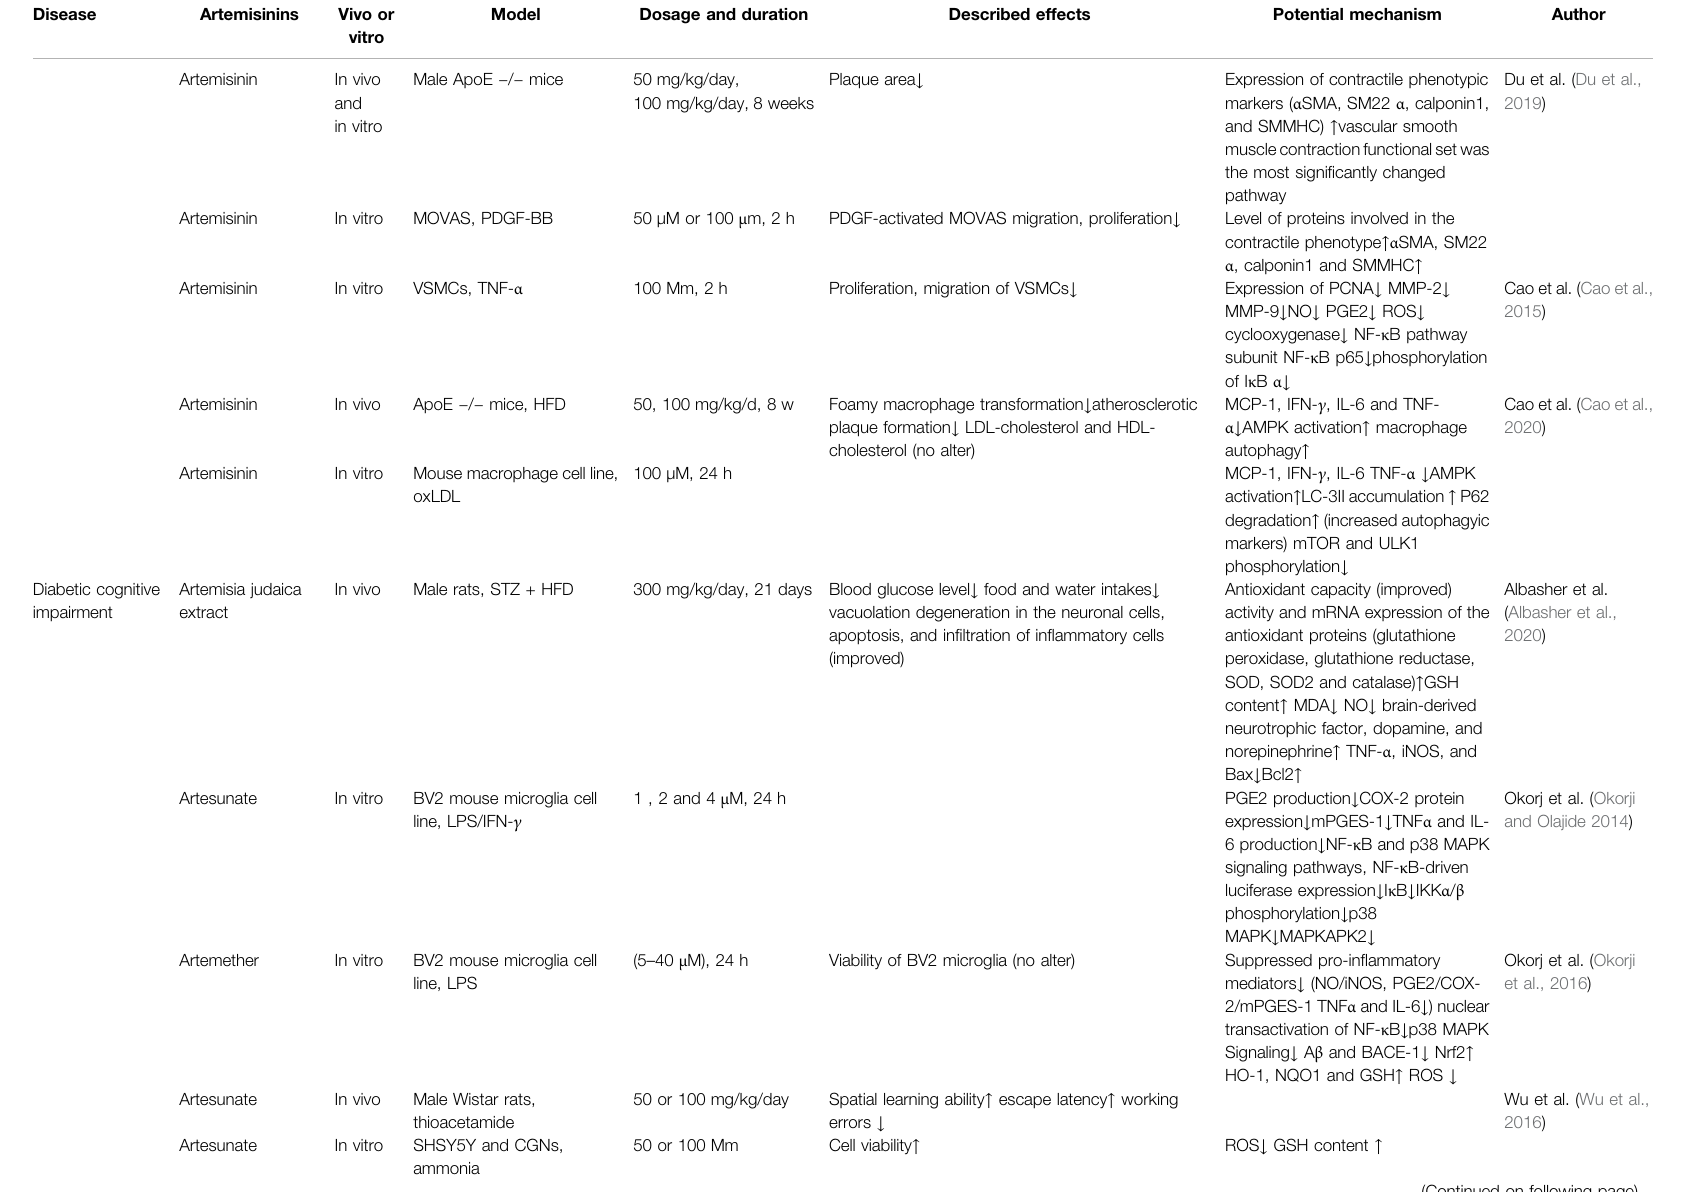
TABLE 2 | ( Continued ) Effects of Artemisinins on T2DM Associated